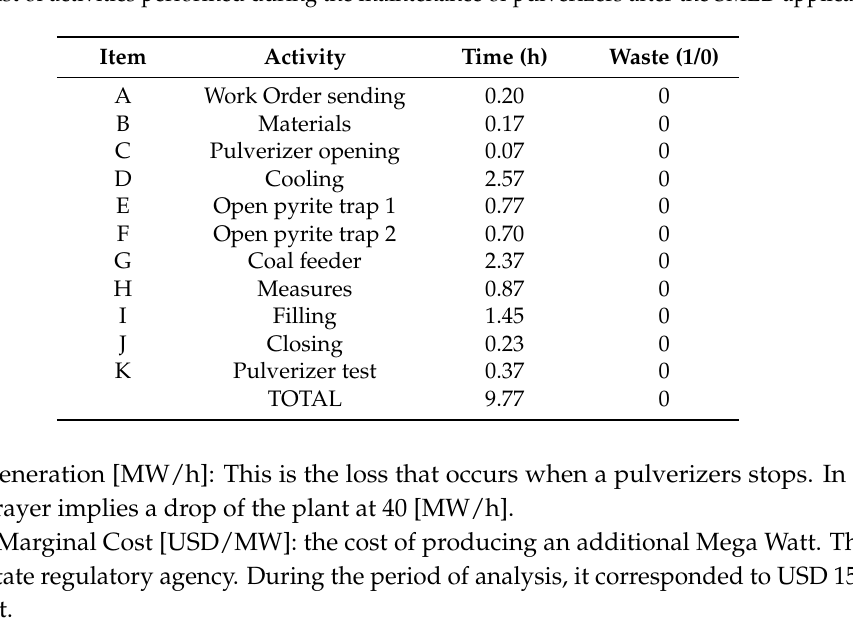
Table 8. List of activities performed during the maintenance of pulverizers after the SMED